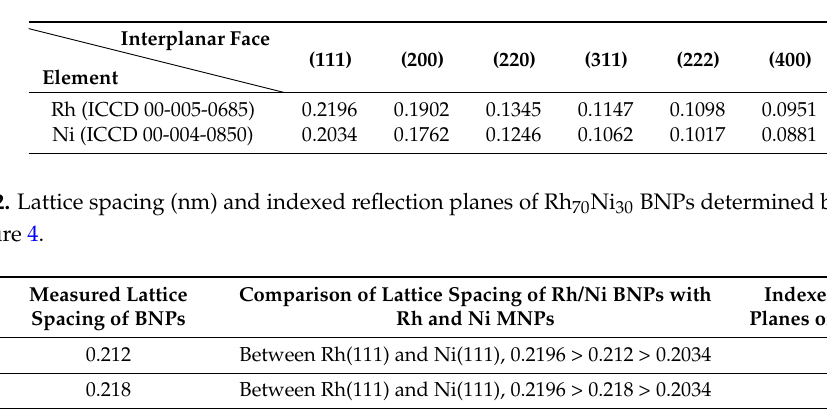
Figure 4. High ‐ resolution transmission electron microscopy (HRTEM) image of as ‐ prepared Rh 70 Ni 30 Figure 4. High-resolution transmission electron microscopy (HRTEM) image of as-prepared Rh 70 Ni 30 BNPs ( R ISO = 40, C Metal = 0.66 mM, reduced under ice-water bath for 1 h). Table 1. Lattice spacing (nm) and indexed reflection planes of Rh and Ni. Table 1. Lattice spacing (nm) and indexed reflection planes of Rh and Ni.